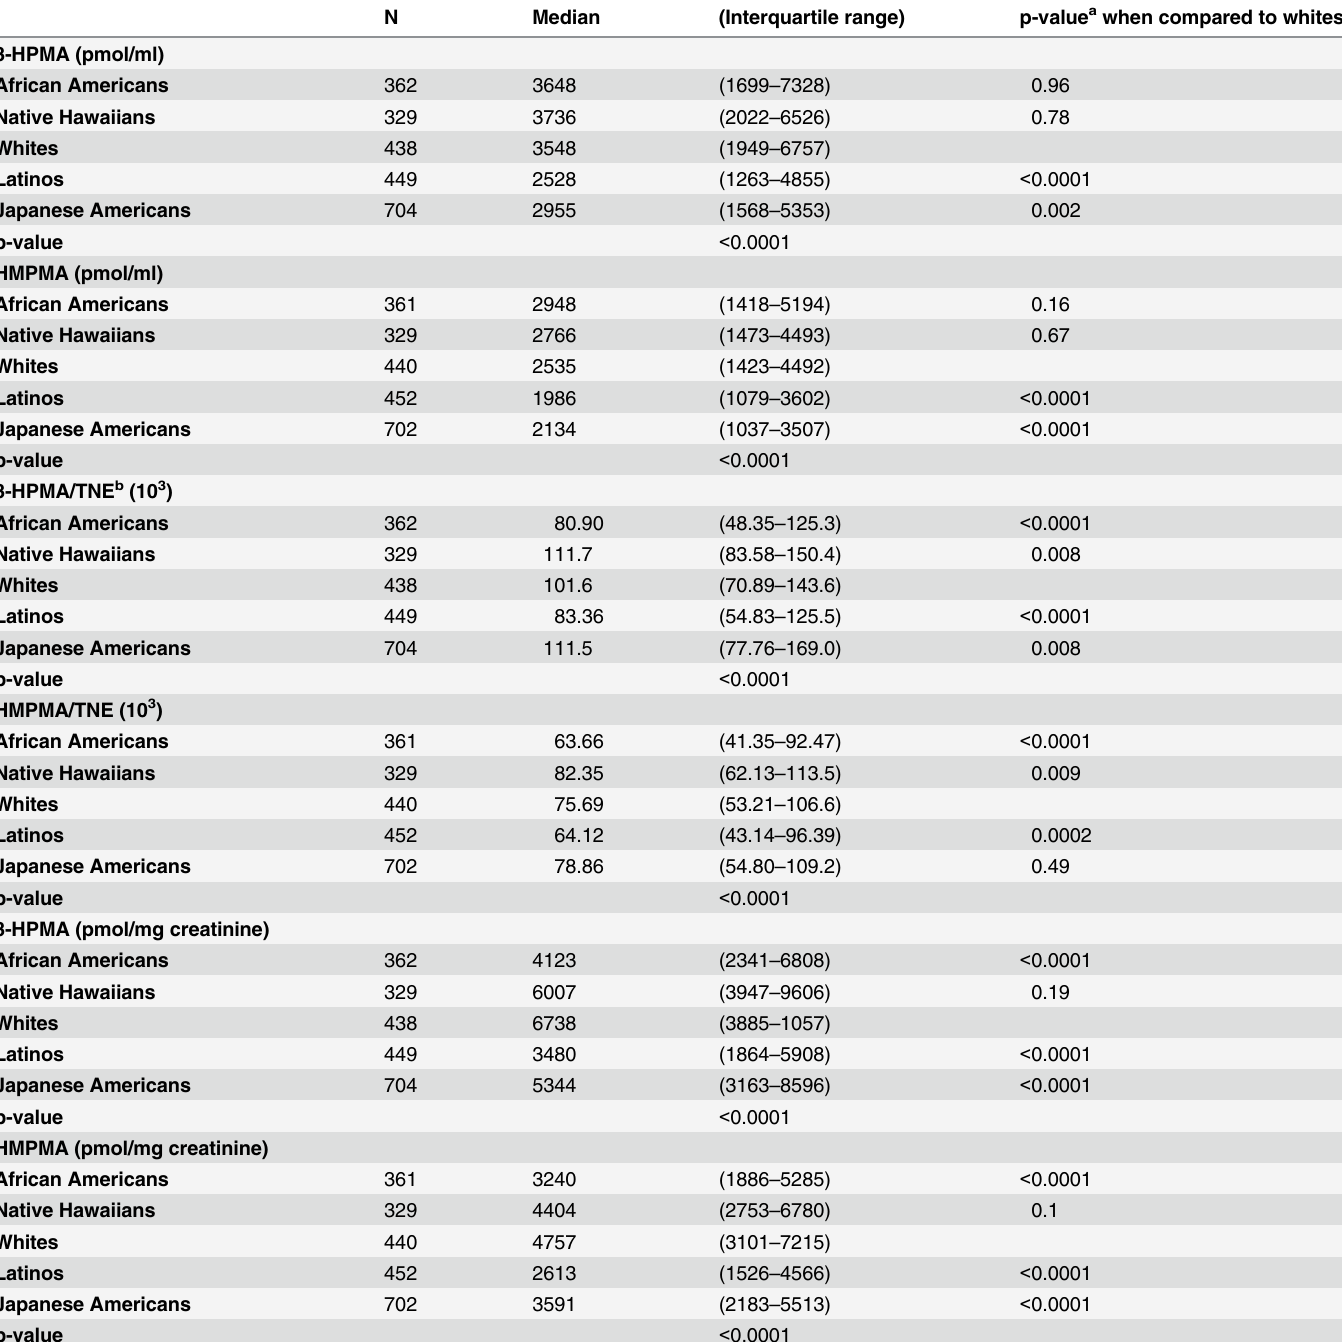
Table 3. Median and interquartile range for measures of 3-HPMA and HMPMA. N Median (Interquartile range) p-value a when compared to